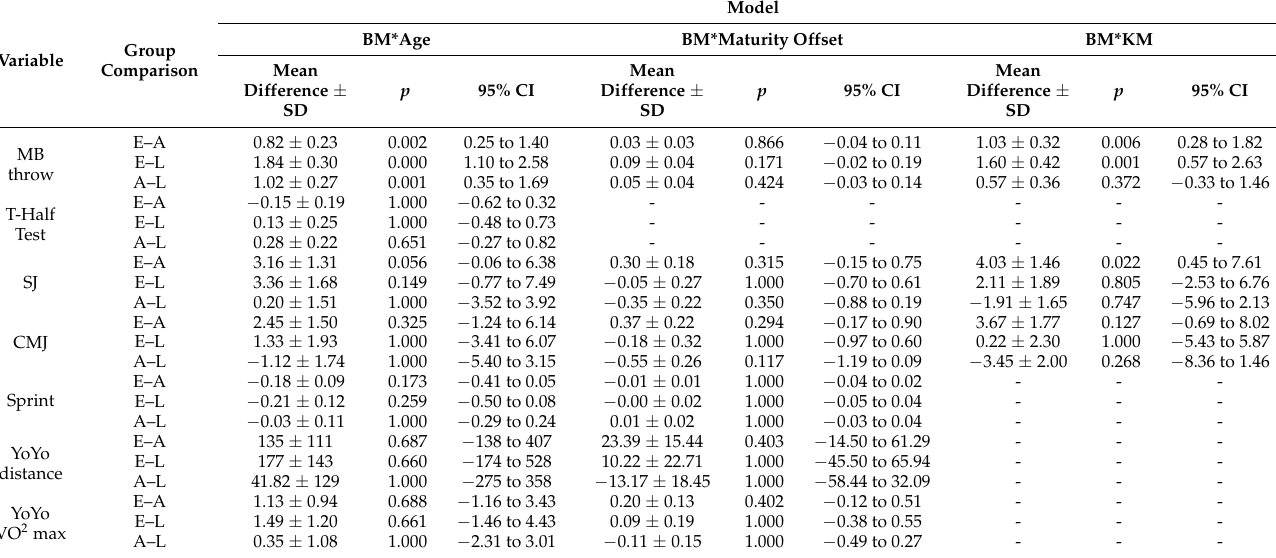
Table 4. Post hoc comparison between biological maturation groups after ANOVA analysis, as a function of the covariates age, maturity offset and KM score, for physical test results.